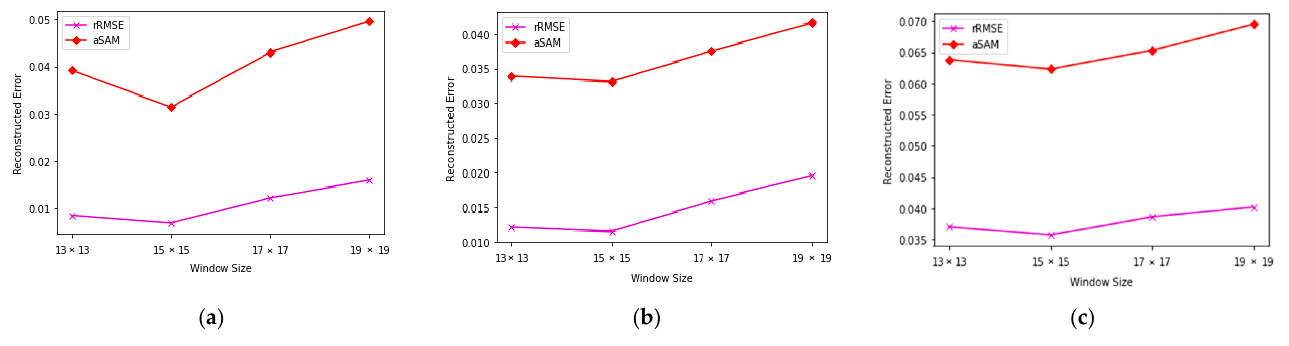
Figure 16. Analysis of spatial window size on the proposed approach. ( a ) Jasper. ( b ) Urban. ( c ) Washington DC Mall.